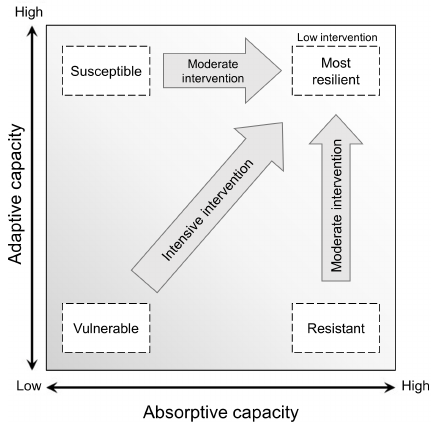
Figure 3. “Resilience canvas” with absorptive and adaptive capac- ities as two axes, showing resilient–vulnerable gradient, resilience conditions, and pathways to resilience. The four dashed rectangles illustrate resilient, resistant, susceptible, and vulnerable system con- ditions. The grey arrows represent pathways, or a series of concerted interventions designed to drive systems from one condition to an-